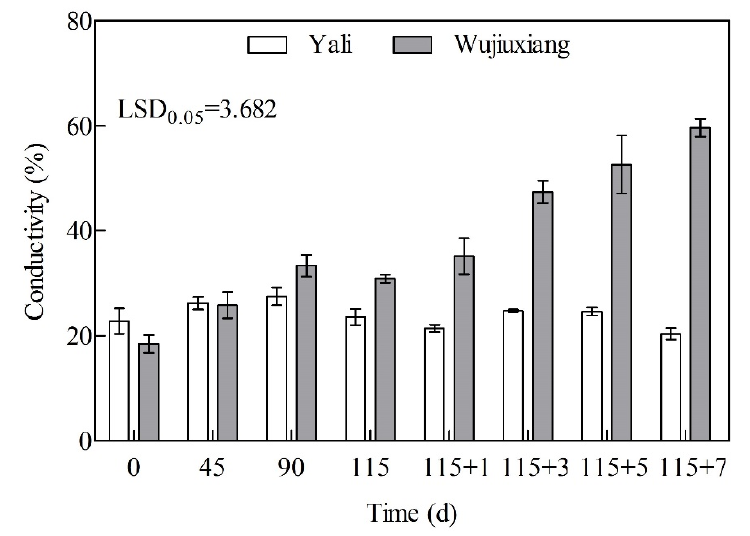
Figure 6. The relative conductivity of the peels of ‘Yali’ and ‘Wujiuxiang’ pear during cold storage and the shelf life. Vertical bar represents the standard error and LSD values indicate significant differences at the level of 0.05. Note: 115 + 1, 115 + 3, 115 + 5, and 115 + 7 indicate 1, 3, 5, and 7 days of shelf life at room temperature (20 °C) after cold storage at 0 °C for 115 days.